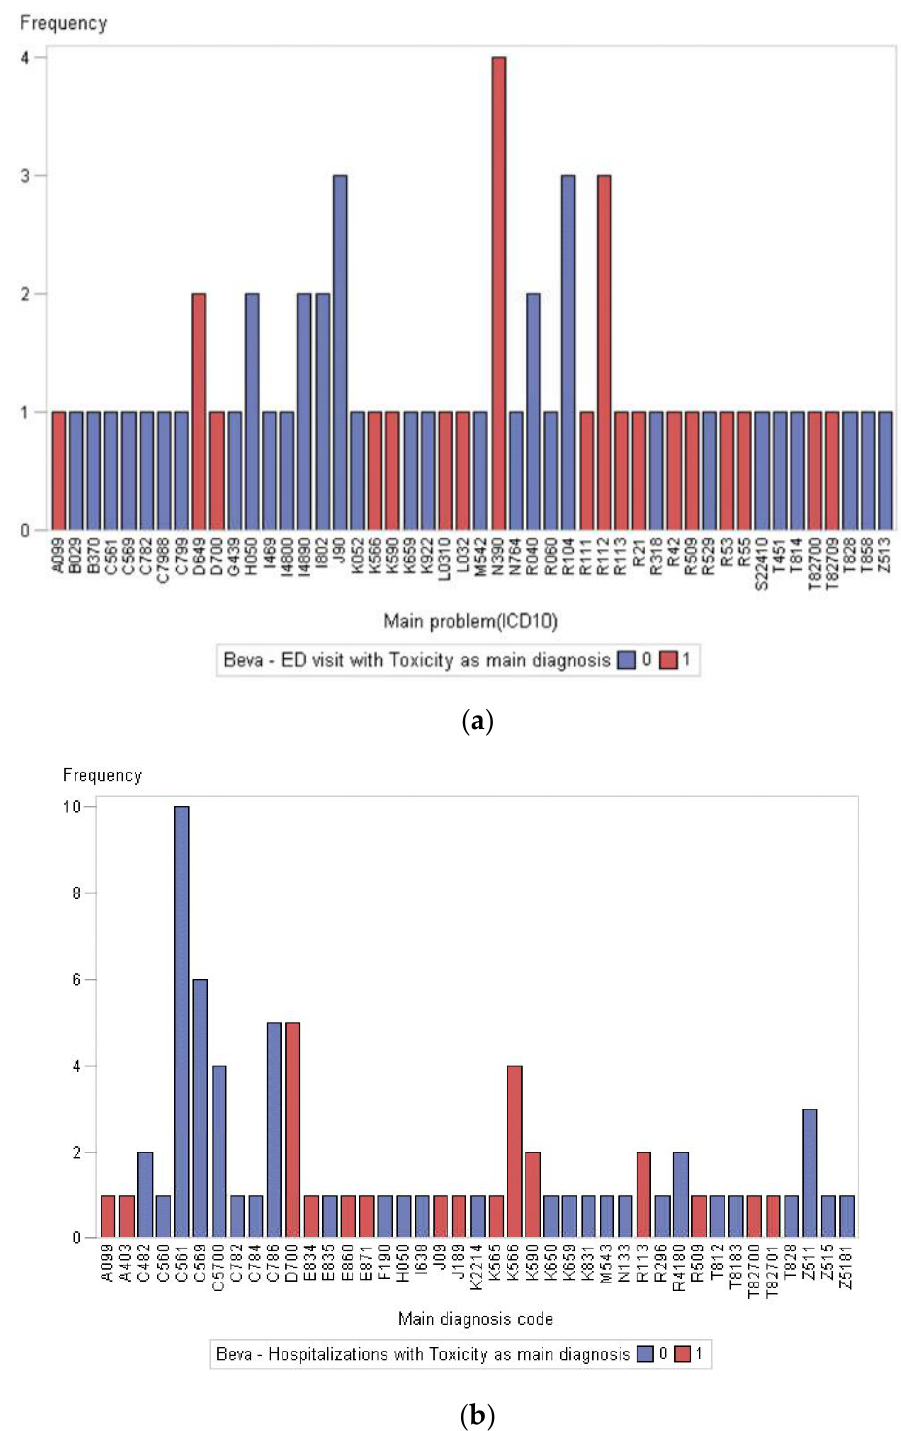
Figure 3. ( a ). ICD-10 codes of ED admission diagnoses during systemic treatment for patients receiving bevacizumab combination in first-line setting; ( b ). ICD-10 codes for hospital admission diagnoses during systemic treatment for patients receiving bevacizumab combination in first-line setting. 0 = no; 1 = yes. For ICD-10 codes listed please refer to https://www.icd10data.com/ICD10CM/Codes (accessed on 11 February